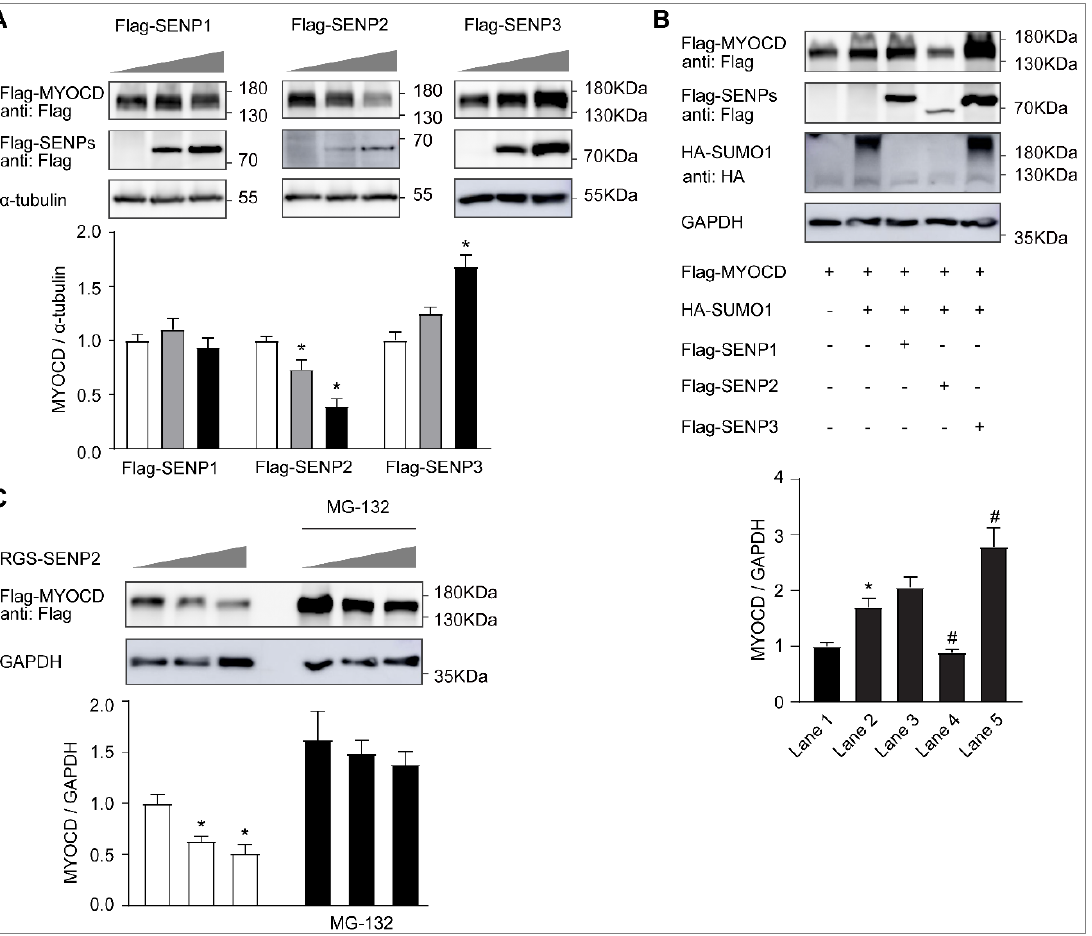
Figure 4. SENP2 promotes proteasome ‐ dependent degradation of myocardin. ( A ) HEK ‐ 293T cells were transfected with Flag ‐ myocardin (Flag ‐ MYOCD) and increasing amounts of Flag ‐ SENP1, Flag ‐ SENP2, or Flag ‐ SENP3 for 24 h. The levels of Flag ‐ MYOCD in whole ‐ cell lysates were determined by Western blotting with anti ‐ Flag and anti ‐α‐ tubulin antibodies (n = 3, * p < 0.05). ( B ) HEK ‐ 293T cells were transfected with Flag ‐ MYOCD, HA ‐ SUMO1, and Flag ‐ SENP1, Flag ‐ SENP2, or Flag ‐ SENP3 for 24 h. Lysates were prepared and analyzed by Western blotting (n = 3, * p < 0.05 vs. Lane 1, # p < 0.05 vs. Lane 2). ( C ) HEK ‐ 293T cells were transfected with Flag ‐ MYOCD and increasing amounts of RGS ‐ SENP2 for 24 h, in the presence or absence of MG132 (10 μ M) for the last 10 h. Lysates were prepared and analyzed by Western blotting (n = 3, * p < 0.05). Taken together, these results suggest that SUMO ‐ 1 promotes the protein stability of myocardin, whereas SENP2 facilitates its proteasome ‐ dependent degradation.